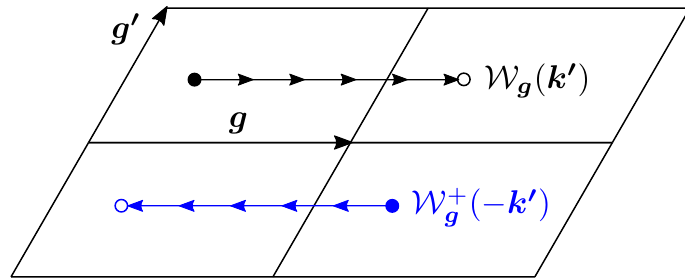
( k (cid:48) ) applied in W g